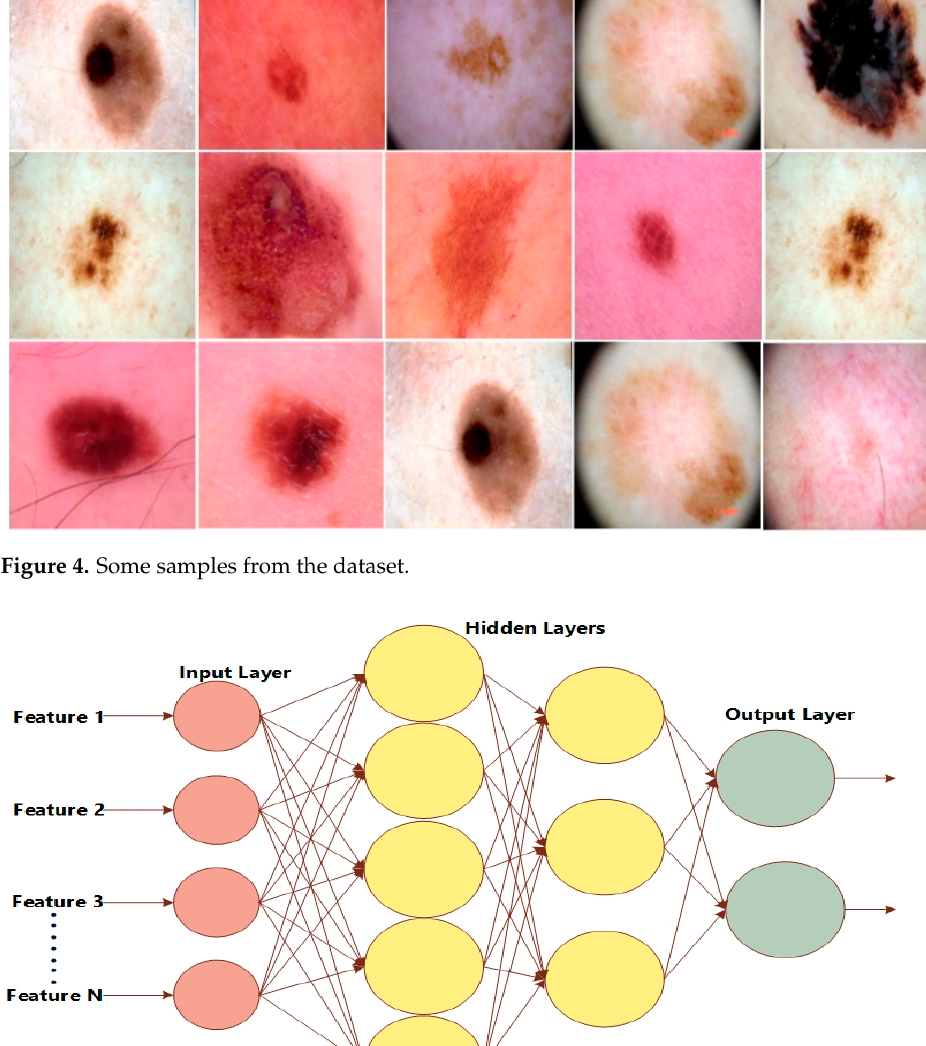
Figure 5. The structure of LSTM .